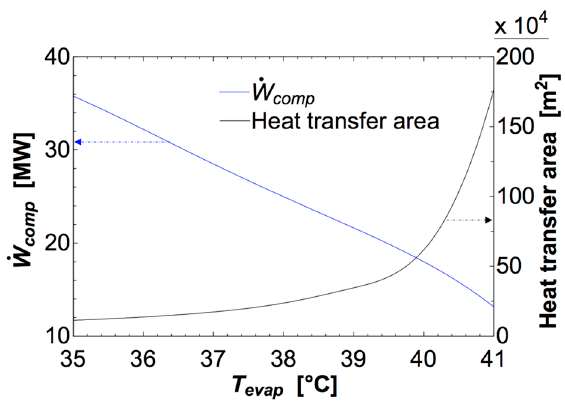
Figure 6. Secondary loop evaporator heat transfer area and compression work change with secondary loop evaporating temperature.